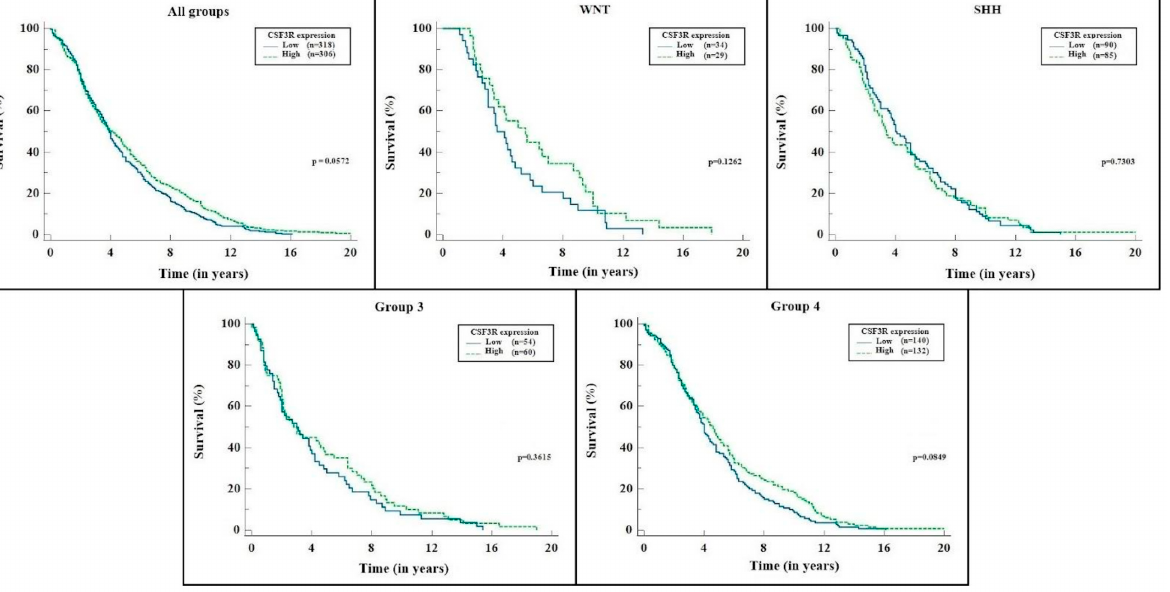
Figure 4. CSF3R expression × survival (median) for each molecular group and total sample. Source: the authors. Compiled using MedCalc ® version 20.115 (Med- Calc Software Ltd., Ostend, Belgium).